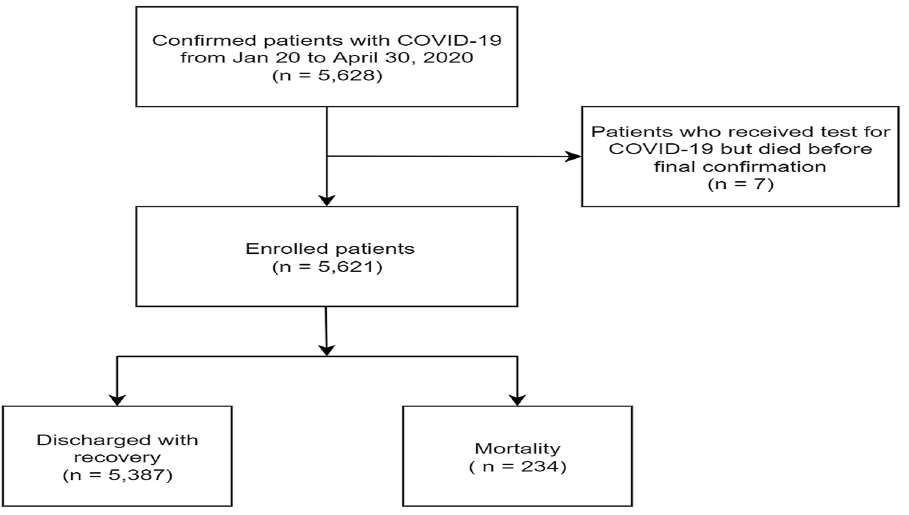
Figure 1. Flowchart of the study